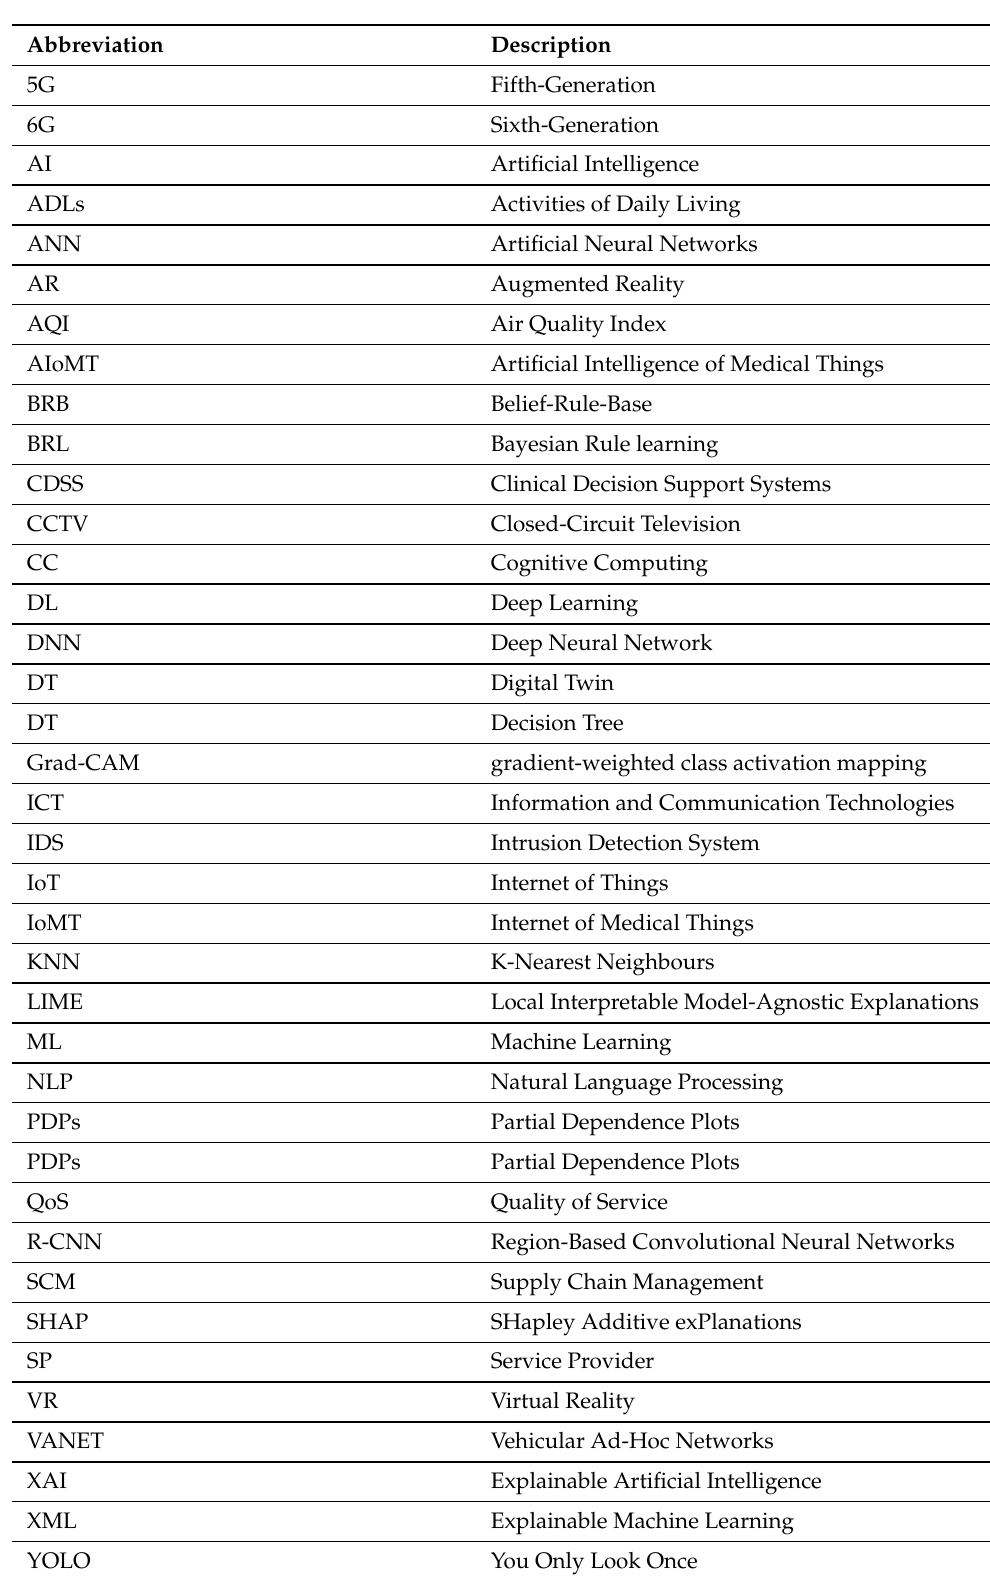
Table 2. List of